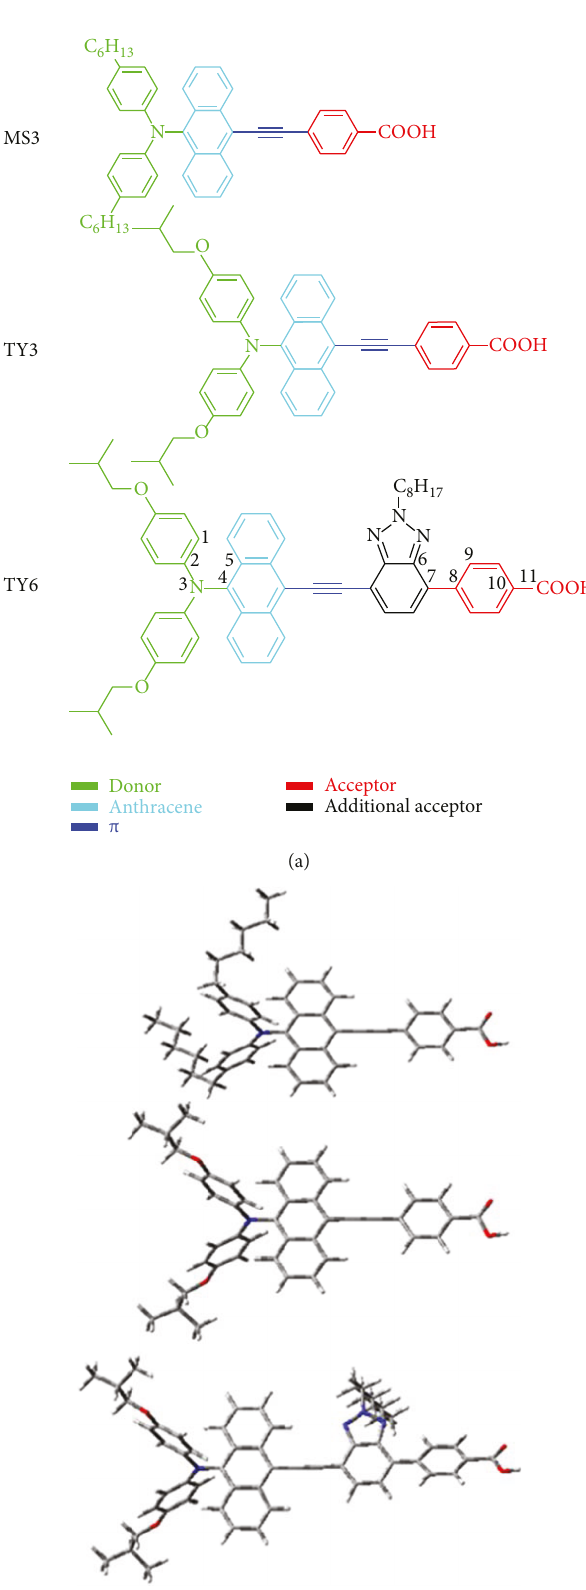
Figure 1: (a) Chemical structures of MS3, TY3, and TY6. (b) Side view for dyes optimized at the B3LYP/6-31G(d)